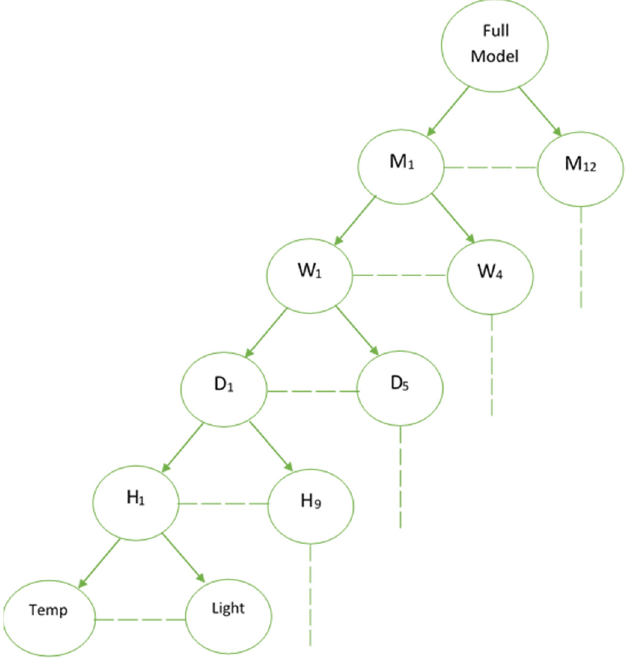
Figure 2. State space decomposition.